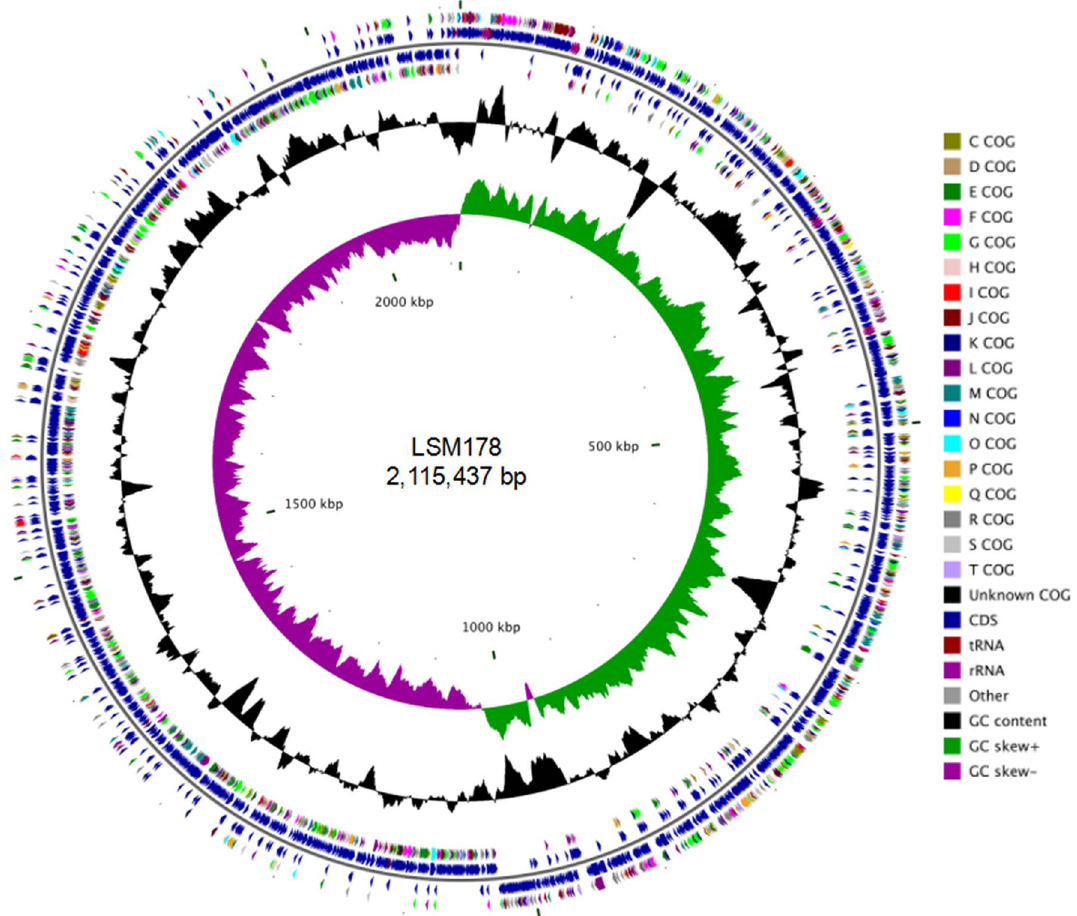
Figure 3. The circular diagram of the LSM178 genome. From inside to outside, the first circle, the scale of genome; the second circle, GC skew; the third circle, GC content; the fourth and seventh circles, the COG category of coding sequence (CDS) on two strands; the fifth and sixth circles, the position of CDS, tRNA and rRNA on two strands. The image was generated by online website CGView Server BETA (http:// cgview. ca/). Antibiotics MIC